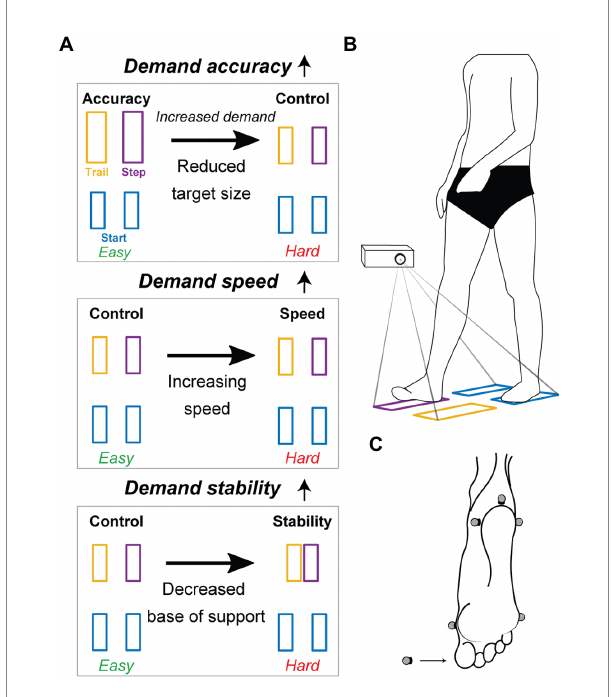
FIGURE 1 Graphical impression of the experimental protocol. The effect of increasing accuracy, speed, and stability demands on stepping was tested by assessing the change in stepping outcomes as a result of reducing target size, increasing speed, and decreasing the base of support (panel A top to bottom). The horizontal arrows in panel (A) indicate in which conditions demand was increased. Subjects were asked to step into targets projected from standstill (panel B ). In panel (A,B) , starting targets (blue), the stepping leg target (purple), and the trailing leg target (yellow) are positioned as for a right dominant subject. Panel (C) shows marker placement to determine positioning of the foot with respect to the targets. Markers were placed on the posterior apex, lateral and medial aspects of the heel, head of metatarsal 1 and 5, and on the nail of the first toe (indicated by the arrow).